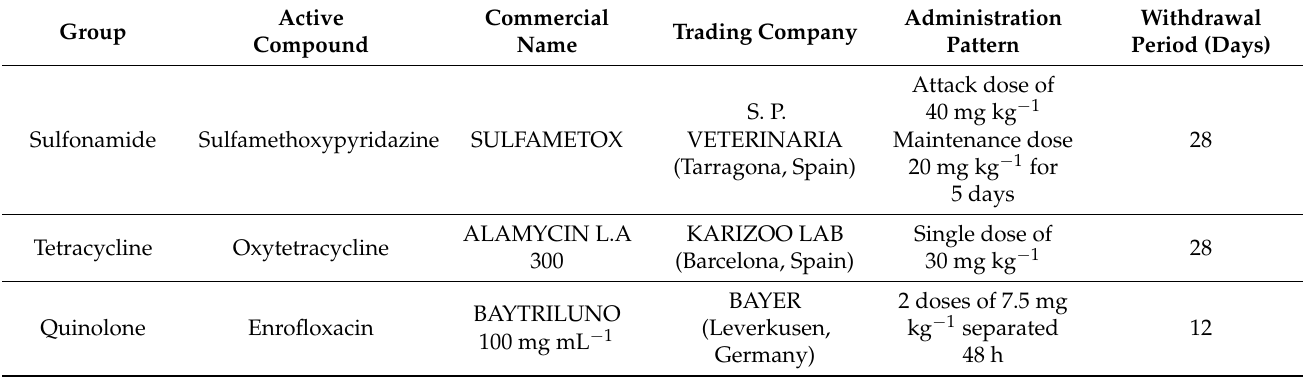
Table 2. Source and main characteristics of the antimicrobials explored. Both administration patterns and withdrawal periods are recommended by the manufacturer of the veterinary products.